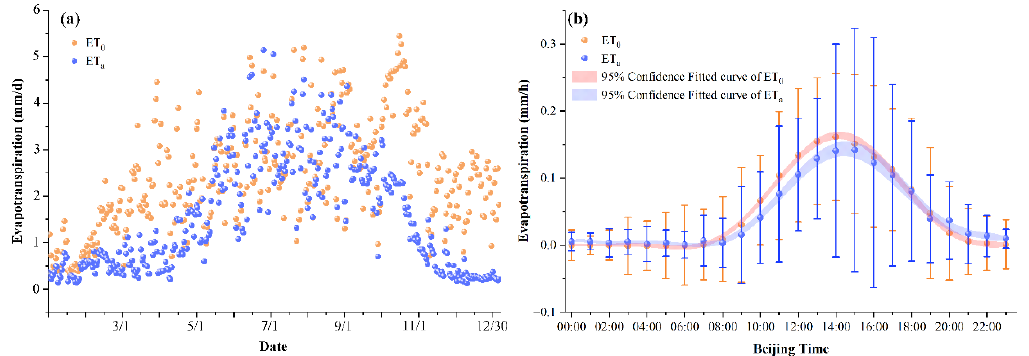
Figure 5. Variations in the ( a ) daily average evapotranspiration; the red squares represent the refer- ence evapotranspiration (ET 0 ) and blue hollow circles represent the actual evapotranspiration (ET a ); ( b ) hourly average evapotranspiration; the red squares represent the reference evapotranspiration (ET 0 ), blue hollow circles represent the actual evapotranspiration (ET a ), the red shadow represents the fitted curve of ET 0 under a 95% confident level, the blue shadow represents the fitted curve of ET a under a 95% confident level, and error bars denote the standard deviation of hourly data.